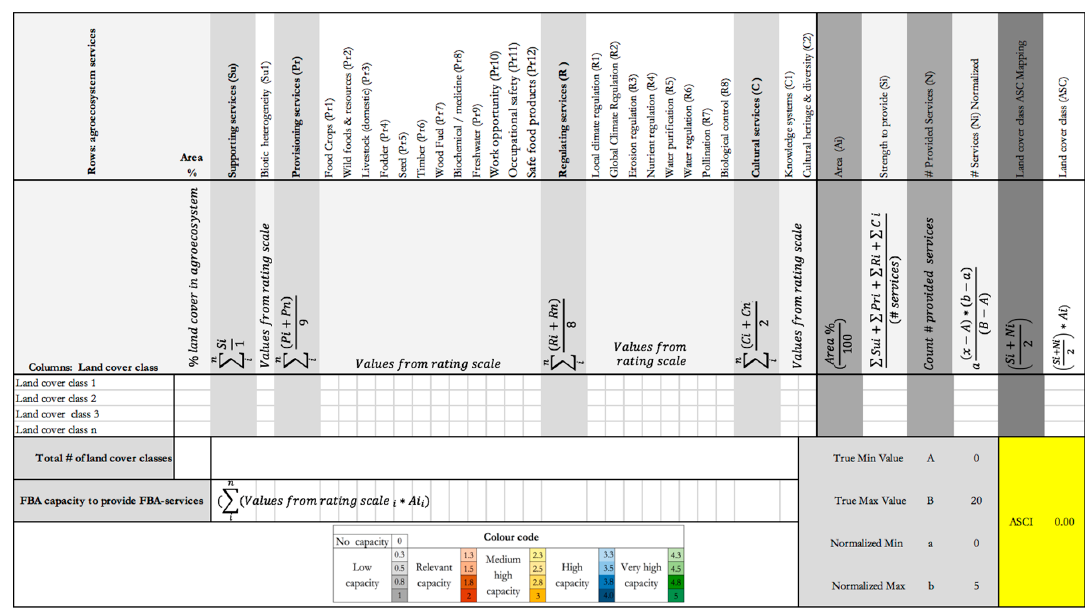
Figure 5. Example of an empty Agroecosystem Service Matrix (ASM)